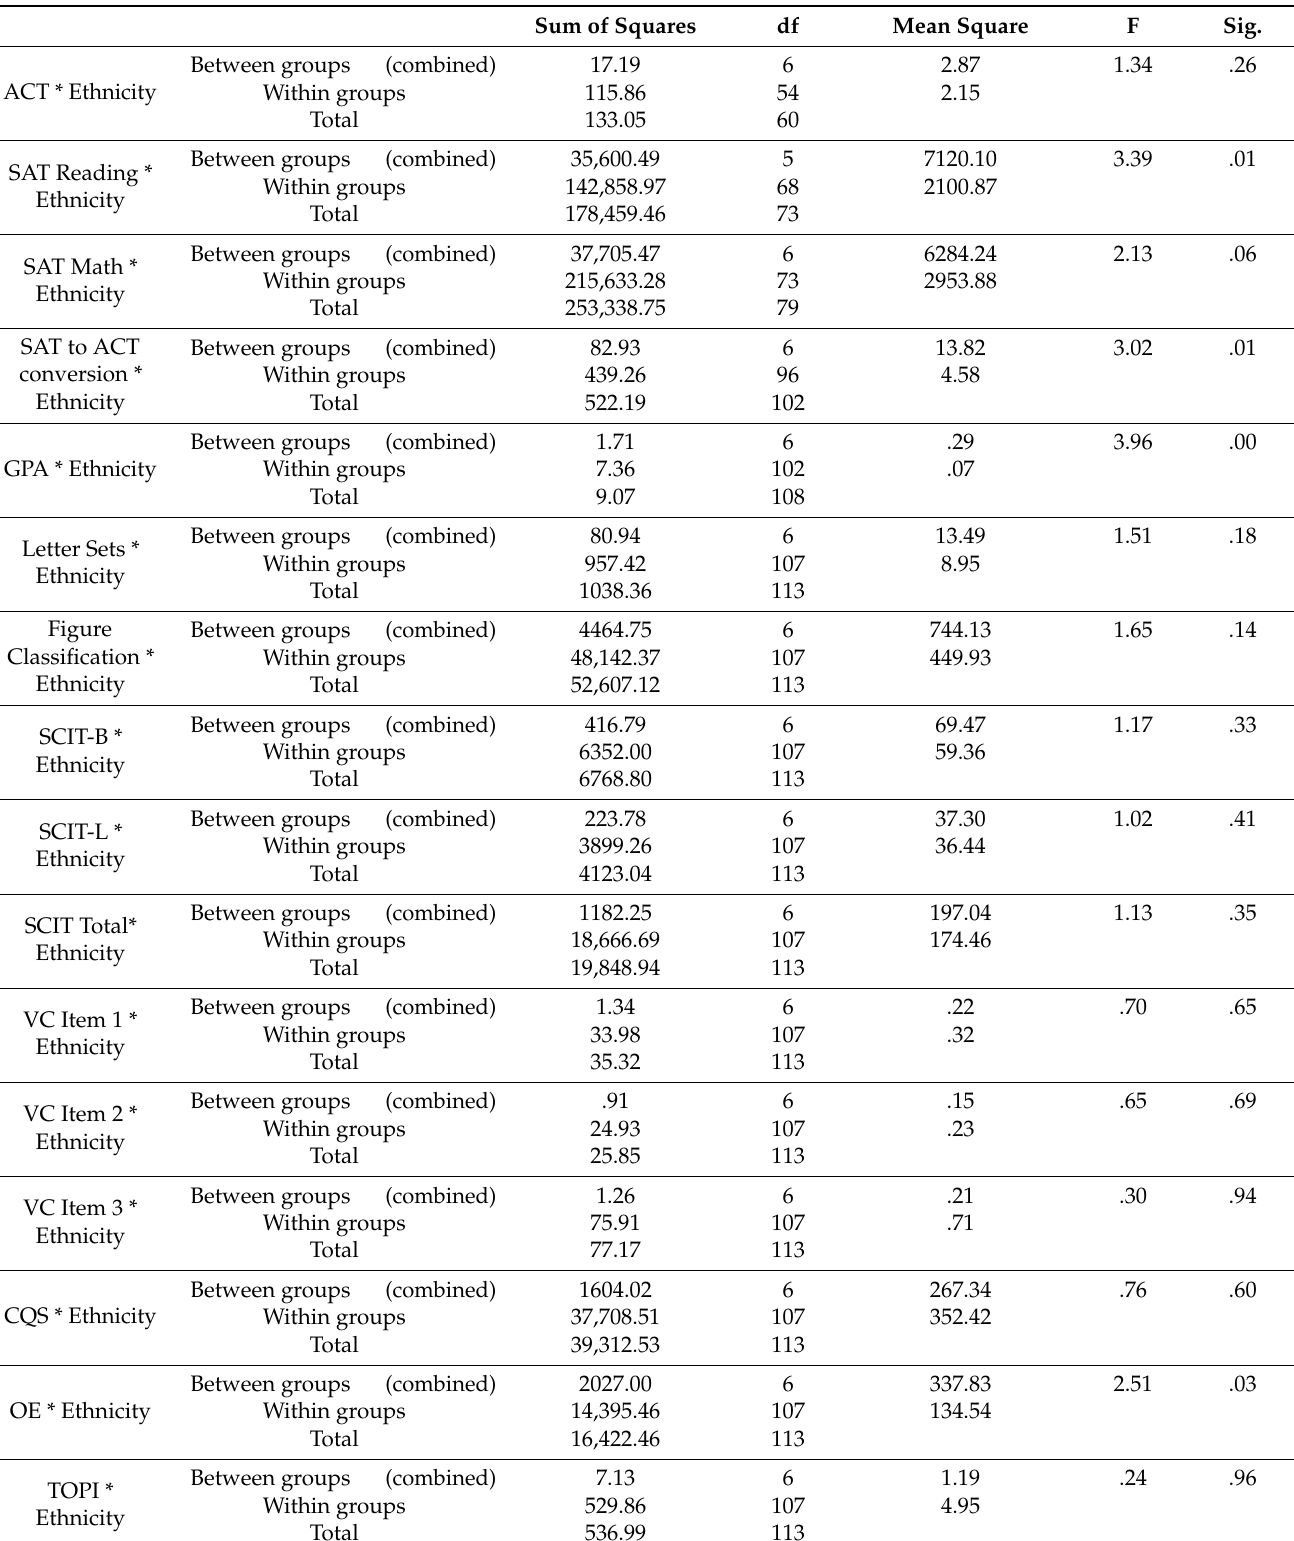
Table 3. Race/Ethnicity-based Analysis of Variance. Sum of Squares df Mean Square F